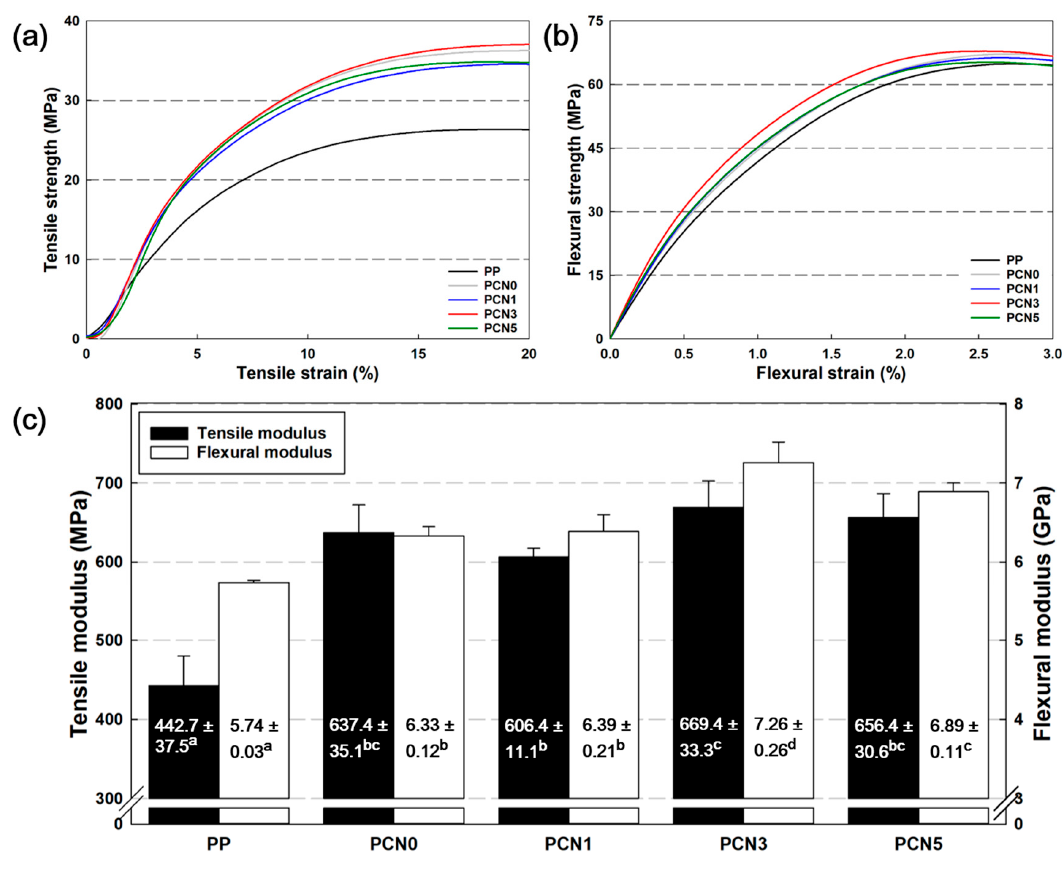
Figure 9. ( a ) Tensile, ( b ) flexural strain–stress (S-S) curves, and ( c ) Tensile and flexural moduli of PP, PP/CNF, and PP/CNF/nanoclay nanocomposites. (Different superscript in same column indicate that they are statistically significantly different at 95% confidence level ( α =0.05))